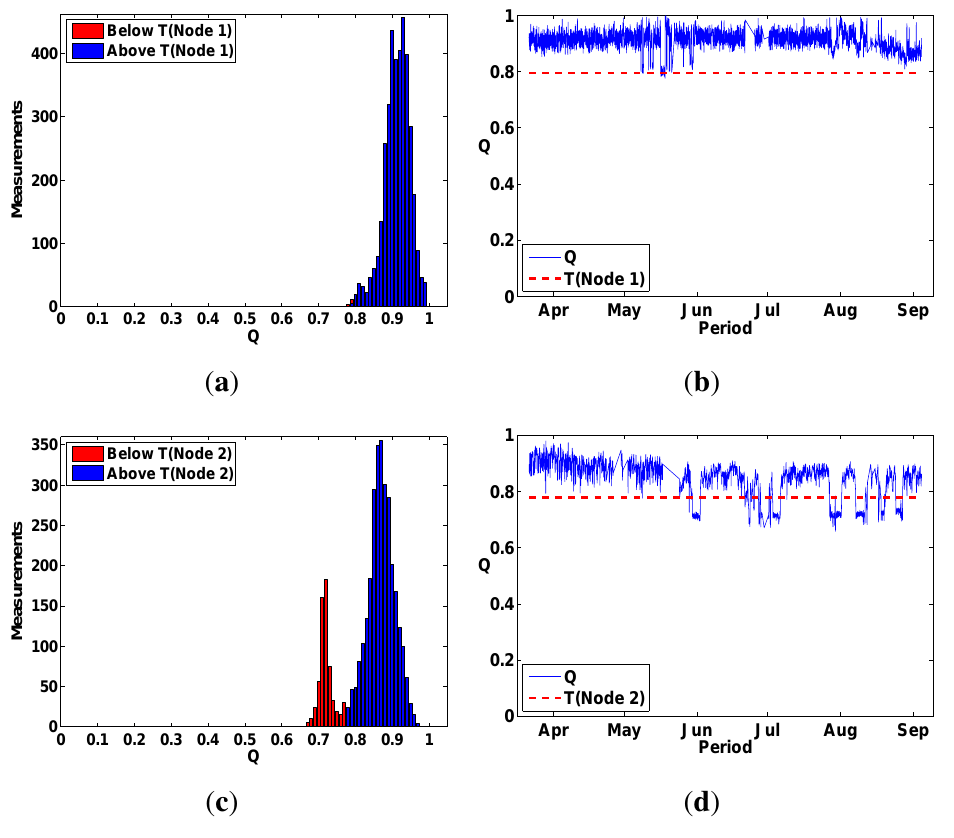
Figure 10. Test Nodes 1 and 2 were placed outdoors for a period of 6 months and measured Q hourly. Q values for Test Node 1 didn’t vary enough to detect any sensor failure. However, Q values for Test Node 2 had a clearly bimodal distribution where fail values could be clearly discriminated from healthy values by using T ( n ) . ( a ) Q distribution Test Node 1 (MC); ( b ) Q values Test Node 1 (MC) 6 months; ( c ) Q distribution Test Node 2 (MC); ( d ) Q values Test Node 2 (MC) 6